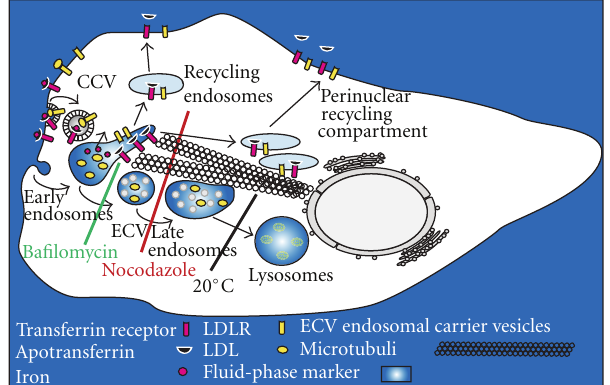
Figure 2: Influence of bafilomycin, nocodazole, and low temper- ature on endocytic pathways in HeLa cells. The recycling pathway (transferrin, LDLR) and the transport of ligands (LDL) and fluid- phase marker to lysosomes are shown. Iron-loaded transferrin binds to its receptor at the plasma membrane. The complex is internalized via clathrin-coated vesicles (CCV) and delivered into early endosomes within 2–5 minutes, where the iron is released and transferred into the cytoplasm. Apotransferrin remains bound to the receptor and recycles via a fast and a slow pathway. At the plasma membrane, apotransferrin is released at the neutral pH. Similarly, internalized LDL is released from its receptor in early compartments allowing for LDLR to return to the plasma membrane via the same pathways as apotransferrin. Although a major portion of fluid-phase marker (e.g., dextran) is recycled, the remaining fluid and released ligands (LDL) are delivered from early endosomes (within 5min), via endosomal carrier vesicles (ECV) and late endosomes (within 15 min), to lysosomes (within 25 min). Transferrin transport to and recycling via the perinuclear recycling compartment is blocked by nocodazole, whereas bafilomycin and lowering the temperature to 20 ◦ C are without e ff ect. In contrast, bafilomycin arrests fluid-phase markers in early endosomes by pre- venting budding of ECV, whereas nocodazole leads to accumulation of cargo in ECV. Finally, incubation at 20 ◦ C prevents delivery of markers from late endosomes to lysosomes. For further details and endosomal pH determination see [105, 108]. Adapted from Fuchs and Blaas